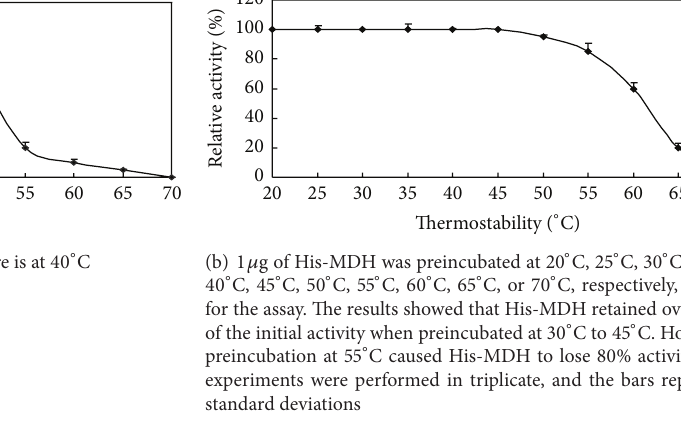
Figure 5: The thermostability of